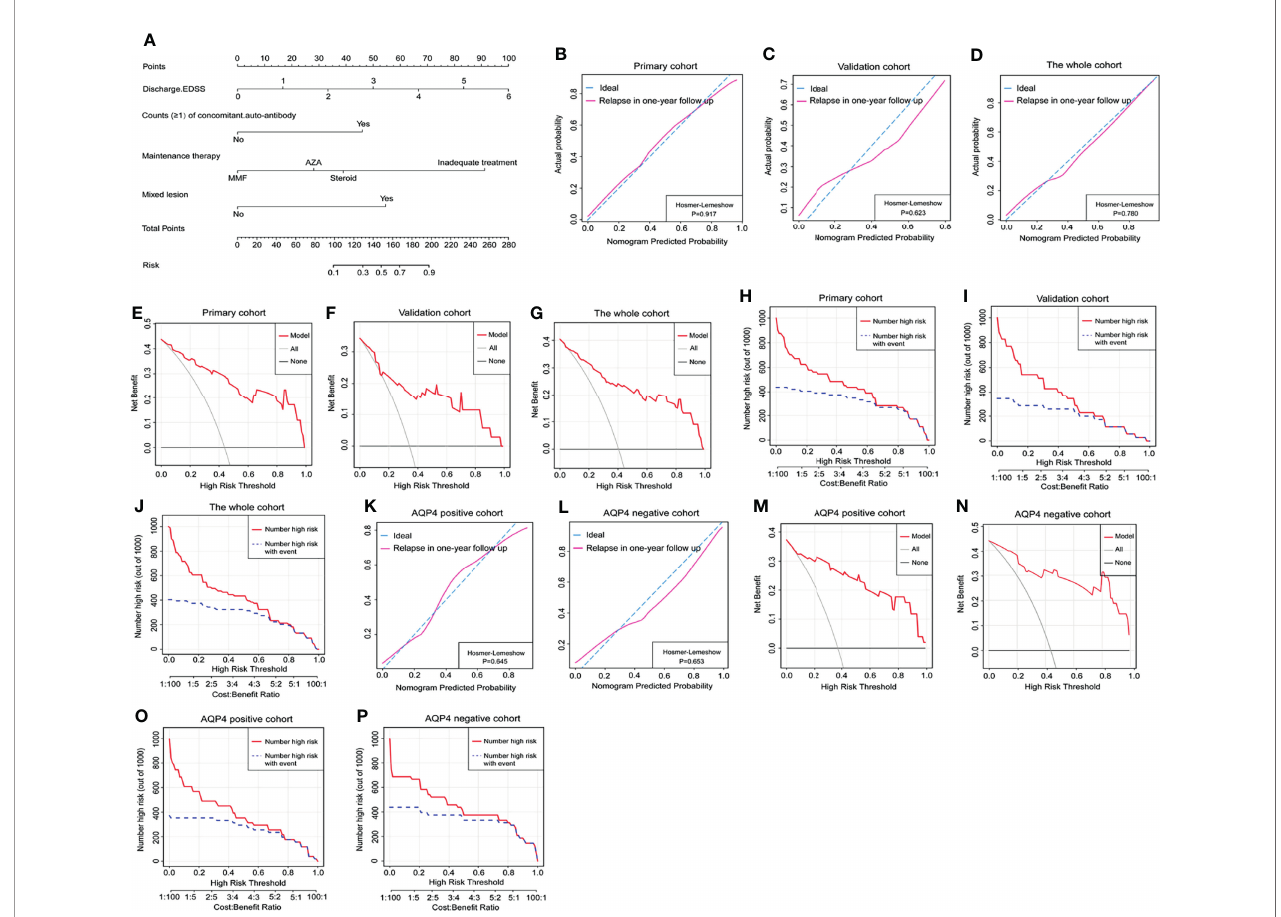
FIGURE 2 | The nomogram model predicted relapse attacks in 1-year follow-up. (A) Nomogram was conveyed to predict the probability of recurrence in 1-year follow-up using 4 independent factors. The calibration curve was a plot to predict the probability of recurrence in 1-year follow-up in the primary cohort (B) , the validation cohort (C) , and the whole cohort (D) . Decision curve analysis of relapse in 1-year follow-up in the primary cohort (E) , the validation cohort (F) , and the whole cohort (G) . The clinical impact curve of nomogram for relapse event in 1-year follow-up in the primary cohort (H) , the validation cohort (I) , and the whole cohort (J) . (K, L) The calibration curve was used to predict the probability of relapse in AQP4 antibody-positive cohort and AQP4 antibody-negative cohort from the whole cohort. (M, N) Decision curve analysis of relapse in 1-year follow-up in AQP4 antibody-positive cohort and AQP4 antibody-negative cohort from the whole cohort. (O, P) Clinical impact curve for relapse in 1-year follow-up in AQP4 antibody-positive cohort and AQP4 antibody-negative cohort from the whole cohort. EDSS, Expanded Disability Status Scale; AZA, acetazolamide; MMF, mycophenolate mofetil; AQP4,